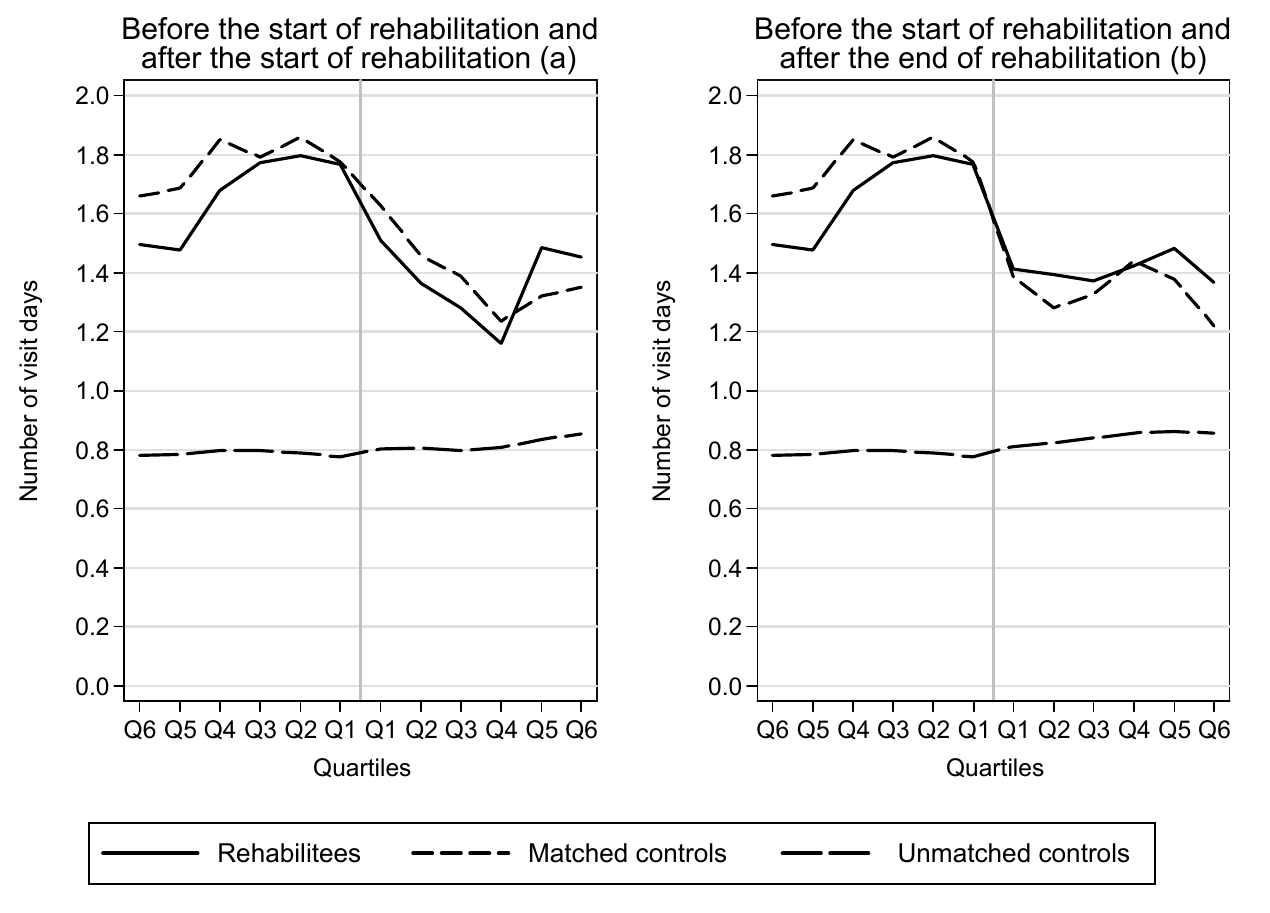
Figure 2. Number of visits in outpatient health care services among rehabilitees and their matched and unmatched controls before the start of rehabilitation and ( a ) after the start of rehabilitation and ( b ) after the end of rehabilitation.